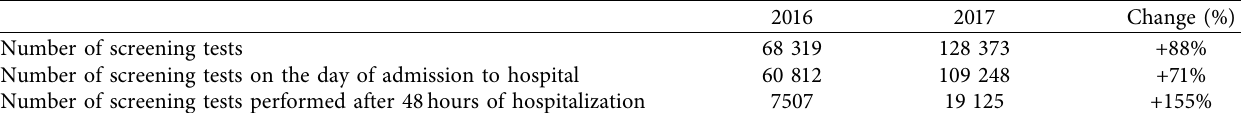
Table 2: Number of microbiological screening tests performed in hospitals in the Mazovian Voivodeship in 2016–2017.